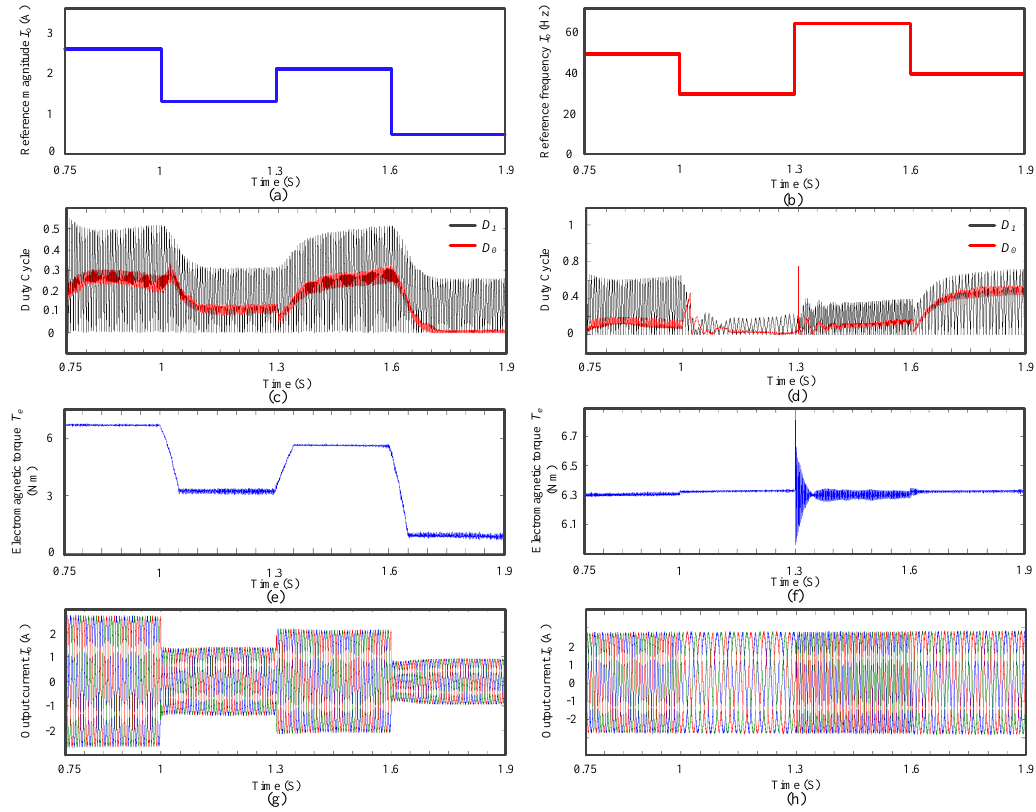
Figure 14. Dynamic response to changing magnitude and frequency in the output current ( a ) The reference point of output current for magnitude; ( b ) The reference point of output current for frequency; ( c ) D 0 and D 1 variation in magnitude changes; ( d ) D 0 and D 1 variation in frequency changes;